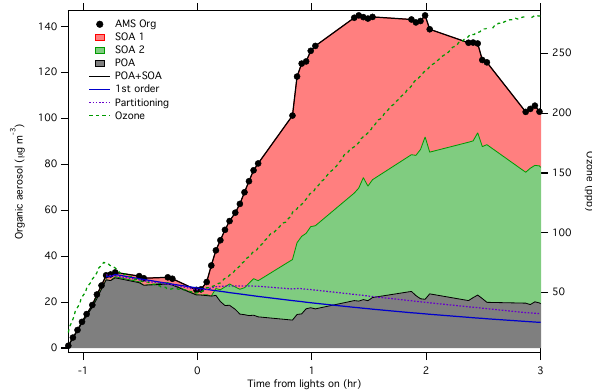
Figure 2. Time series of a typical gas-turbine engine experiment (T63-1). Non-wall-loss-corrected OA mass and O 3 concentration are shown. Red, grey, and green shading indicate the results of a 3-factor PMF solution with one POA factor and two SOA factors. The blue line shows a predicted first-order wall loss rate for POA based on black carbon wall loss, and the dashed purple line shows the predicted POA partitioning based on the volatility distribution of the fresh